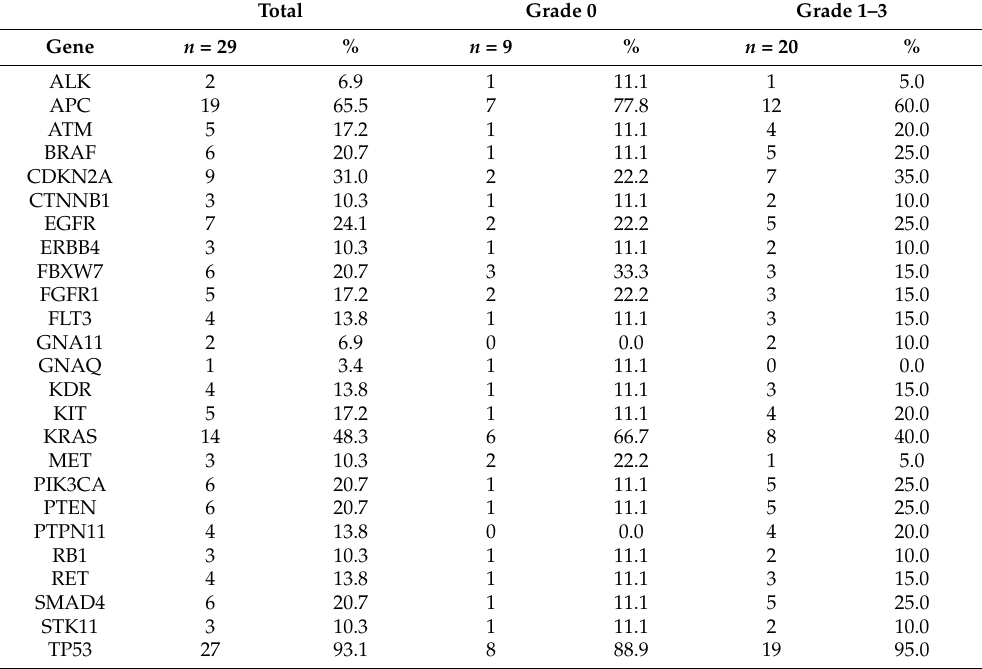
Figure 3. Gene mutation status was examined in biopsy samples from patients with rectal carcinoma. Mutation profiles of biopsy specimens collected from 29 patients with rectal carcinoma before CRT, including 9 patients with grade 0, 11 patients with grade 1, and 9 patients with grade 2 or 3. A green square indicates that a mutation with a frequency of >5% was detected in the gene, a yellow square indicates that a mutation with a frequency of 2–5% was observed in the gene, and an empty square indicates that no relevant mutation was observed for the gene. Table 2. Percentage of individual genes with mutations in patients with rectal carcinoma before and after nCRT.